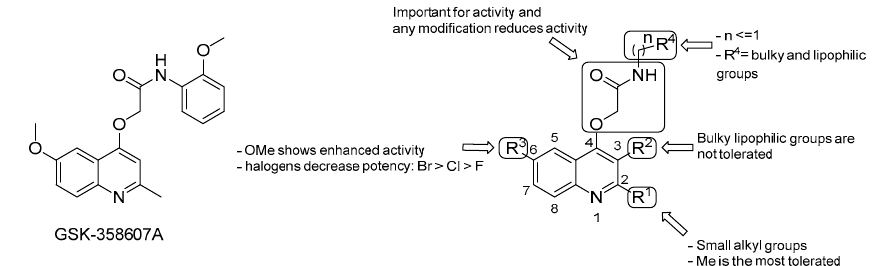
Figure 9. SARs of 2-(quinolin-4-yloxy) acetamides and the chemical structure of GSK-358607A.